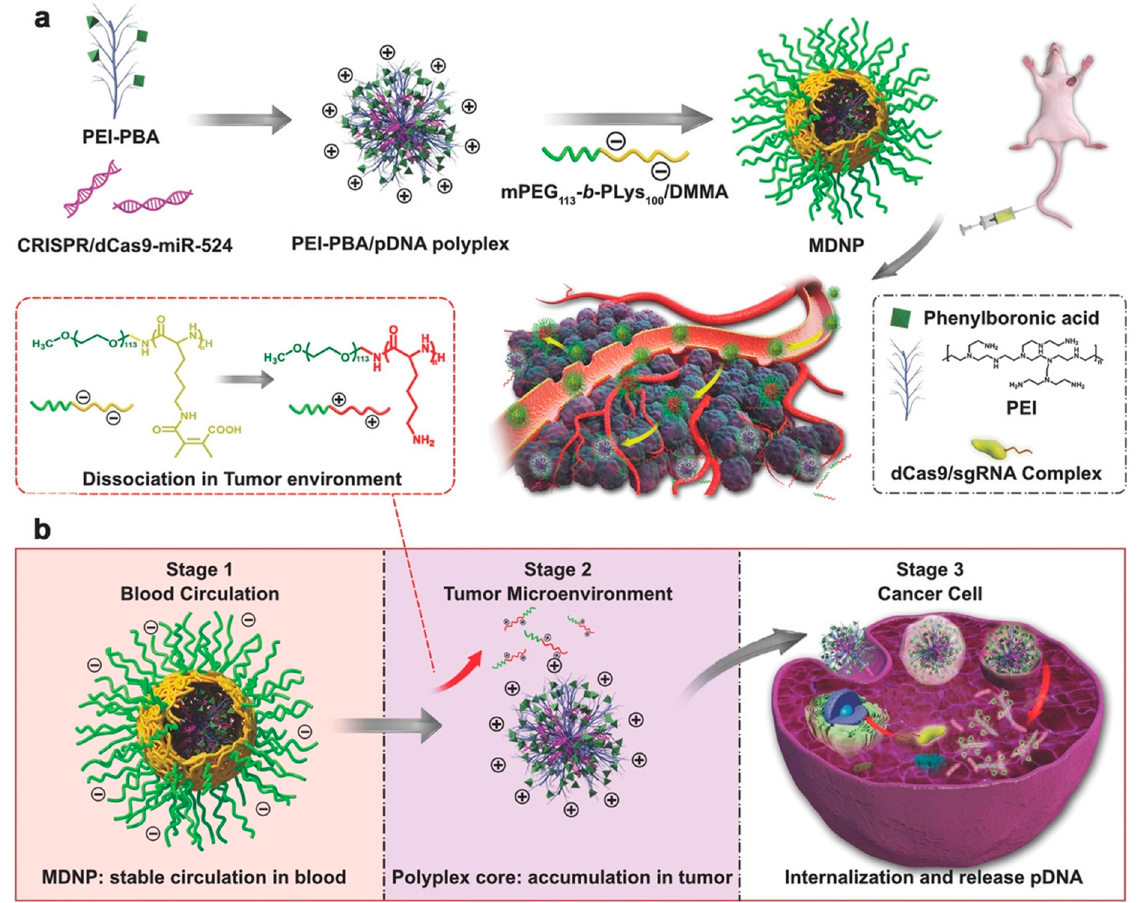
Figure 2. Schematic diagram of PEI/dCas9 to increase the gene expression of the miR524 gene as an anticancer therapy. ( a ) Preparation and delivery of MDNP. ( b ) MDNP delivery from blood circulation to the tumor cells. Reprinted with permission from ref [33]. Copyright 2018, Wiley-VCH.